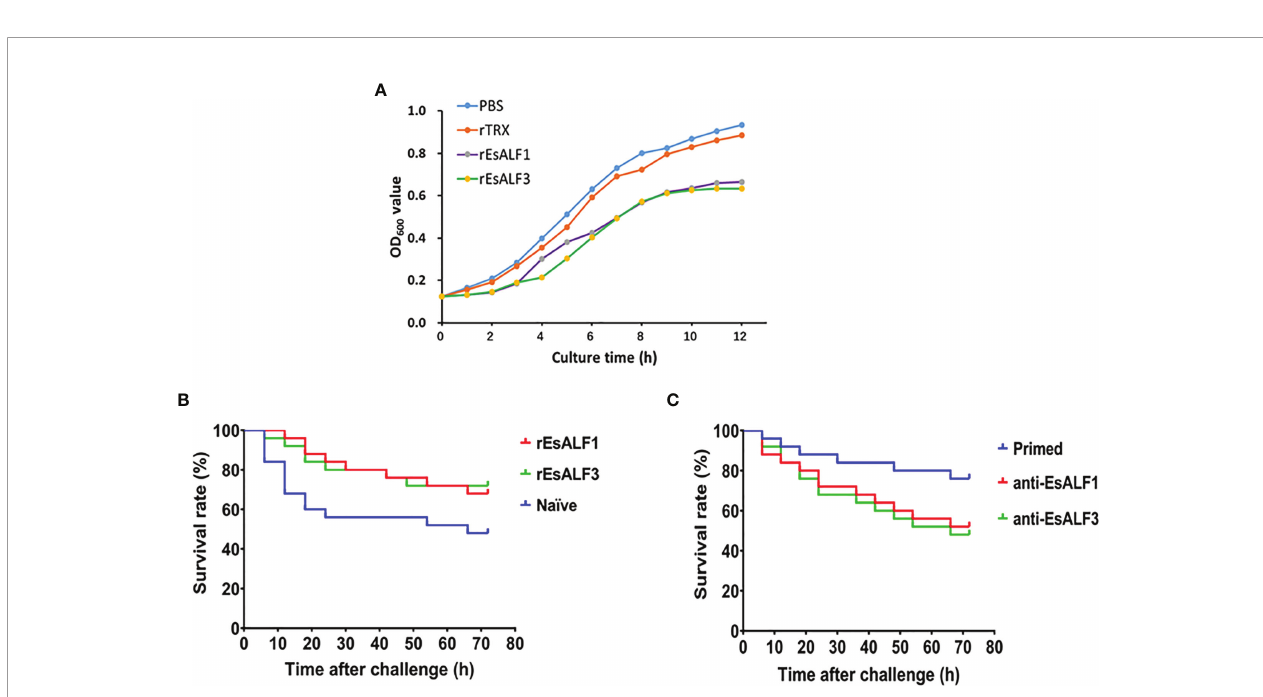
FIGURE 6 | The antibacterial activities of ALFs and impaired resistance after ALFs depletion in haemolymph. (A) The anti-bacterial activities of r Es ALF-1 and r Es ALF- 3 toward A. hydrophila ; (B) The survival rate of blank crabs received r Es ALF-1 or r Es ALF-3 injection ( in vivo over-expression of ALFs); (C) The survival rate of primed crabs (crabs at 7 days after A. hydrophila priming) received anti- Es ALF-1 or anti- Es ALF-3 antibody injection ( in vivo depletion of ALFs).